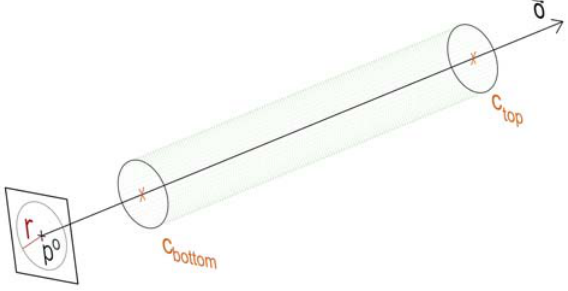
Figure 4. Parameters estimated for a cylinder.